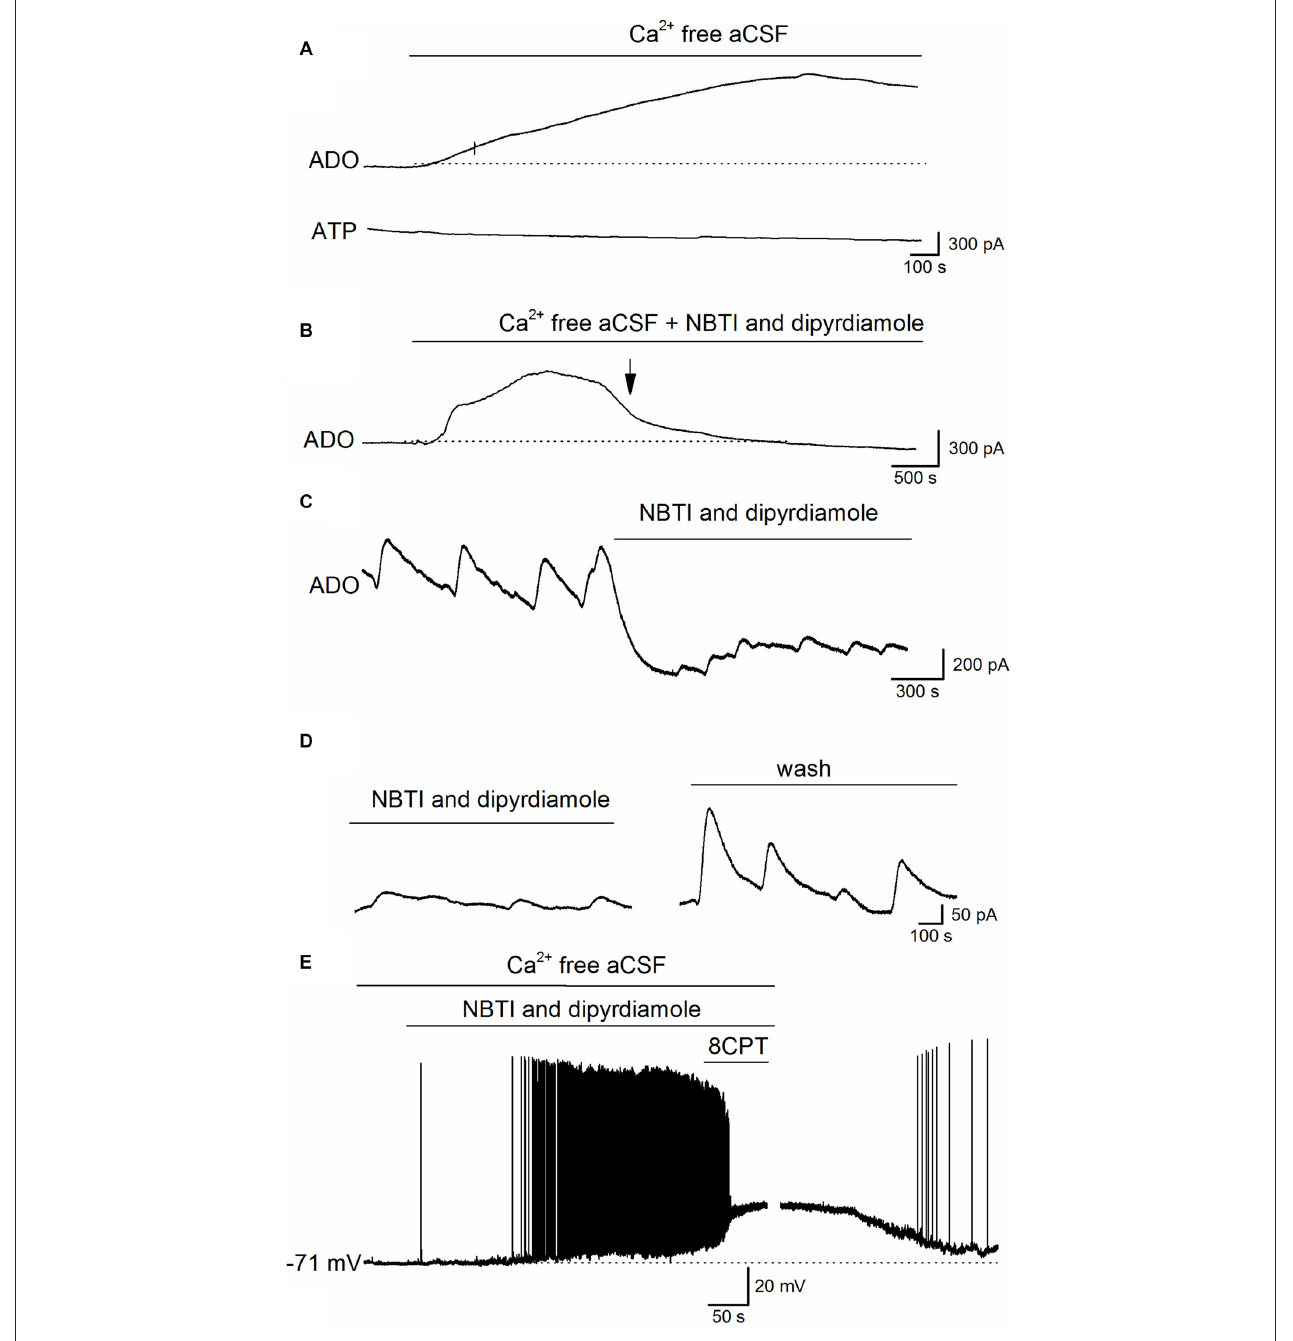
FIGURE 5 | Adenosine is released via equilbrative nucleoside transporters (ENTs) during established Ca 2 + -free activity. (A) Traces from ADO and ATP biosensors during removal of extracellular Ca 2 + . Although there was a clear increase in the ADO biosensor current, no current was observed on the ATP biosensor. (B) Example trace from an adenosine biosensor (ADO). Application of Ca 2 + -free aCSF in the presence of the ENT blockers NBTI (5 µ M) and dipyridamole (10 µ M) induced the initial phases of the increase in extracellular adenosine (and metabolite) concentration but the late phase (phase 3) and the spontaneous release events were abolished (at arrow). (C) Example trace from an ADO biosensor. The spontaneous adenosine release events recorded after 30 min in Ca 2 + -free aCSF are greatly reduced in amplitude ( ∼ 70%) and there is a fall in baseline current induced by the ENT inhibitors NBTI and dipyridamole. (D) Spontaneous release events recorded by an ADO biosensor increase in amplitude following wash of NBTI and dipyridamole. (E) Whole-cell patch-clamp recording from a CA1 pyramidal cell following 30 min incubation in Ca 2 + -free aCSF. Inhibition of ENTs (with NBTI and dipyridamole) induced depolarization and firing of action potentials. Application of 8CPT (2 µ M) to block A 1 receptors produced further depolarization and pushed the cell into depolarization block. Perfusing with aCSF containing Ca 2 + led to a recovery of the membrane potential back to control values illustrating the viability of the recorded pyramidal cell.